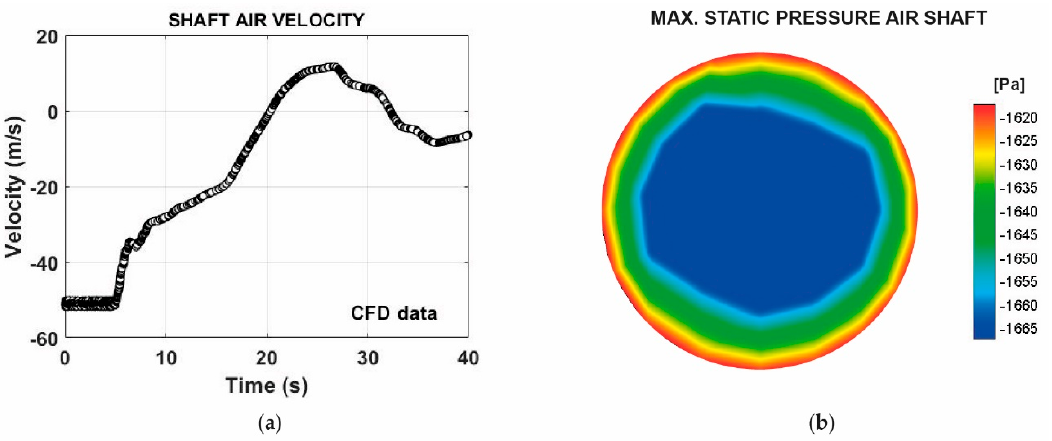
Figure 9. Analysis of air duct during the transient process. ( a ) Air velocity evolution for a closure time of guide vanes of 10 s; and, ( b ) Maximum static pressure.